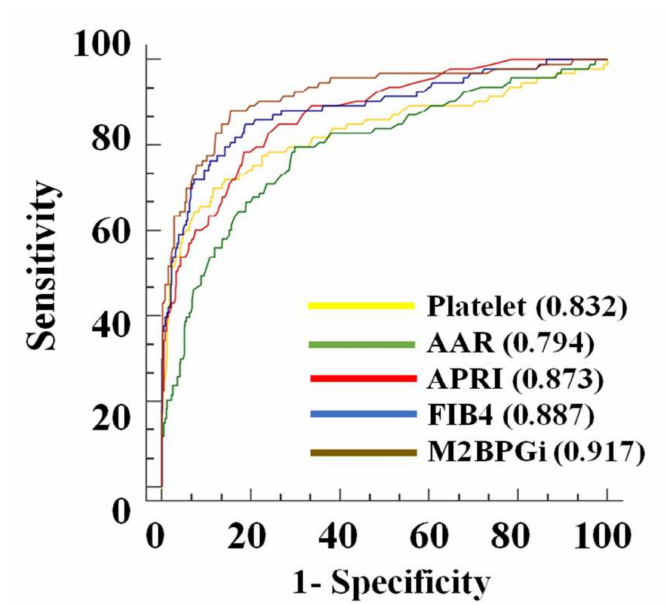
Figure 4. Receiver operating characteristic (ROC) curves for diagnosis of advanced fibrosis in M2BPGi (brown line), FIB-4 (blue line), APRI (red line), AAR (green line), and platelet (yellow line). The AUROC of M2BPGi (0.917) for advanced fibrosis was the highest compared to those of the FIB-4 (0.887), APRI (0.873), platelet (0.832), and AAR